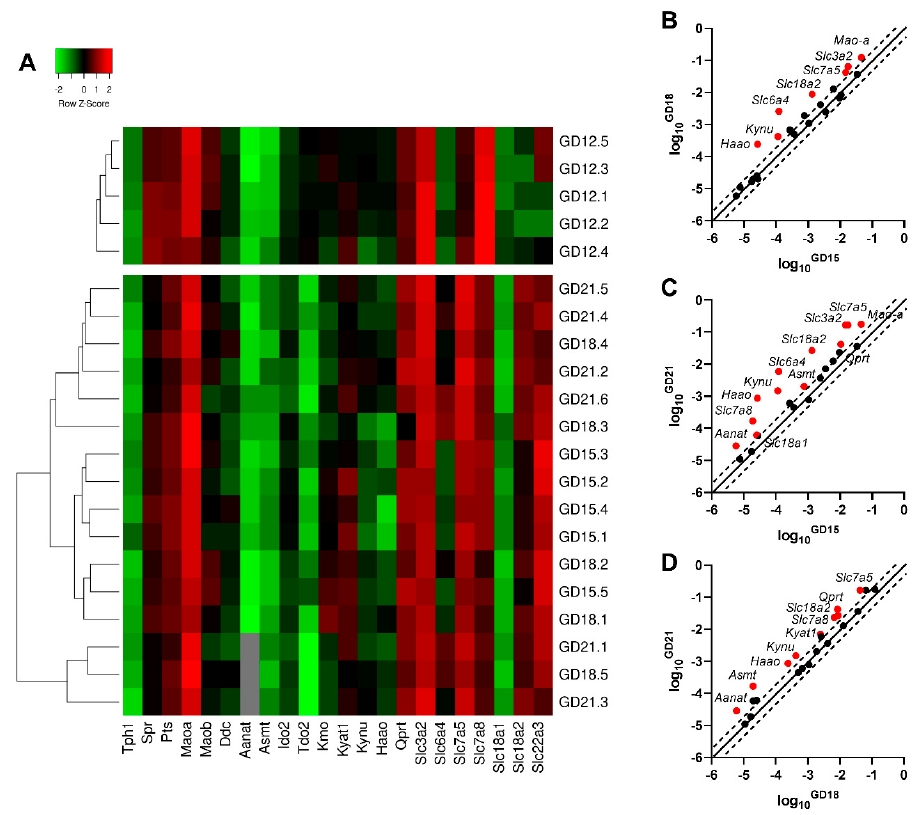
Figure 2. Gene expression of the main enzymes and transporters involved in TRP metabolic pathways in the rat placenta at different stages of gestation. ( A ) Heatmap representing qPCR gene expression analysis in rat concepti (GD 12) and the rat placenta (GD 15, 18, and 21). Average linkage clustering with Euclidean distance measurement reveals changes in gene expression that reflect the different stages of placental development. The color intensity indicates expression levels: red = upregulation; green = downregulation; and gray = not detected. ( B – D ) Identification of enzymes/transporters with significant changes in placental gene expression during gestation. Whilst the pattern of the increase in gene expression is similar for di ff erent stages of gestation, the highest di ff erence is observed between GD 15 and 21. Data are presented as scatter plots with log10 gene expression at GD 18 compared to GD 15 ( B ), GD 21 compared to GD 15 ( C ), and GD 21 compared to GD 18 ( D ). The central diagonal line shows unchanged gene expression, and the dotted lines depict the threshold fold regulation ( = 2). Data were further evaluated using the non-parametric Mann–Whitney test on ∆ Ct values, and those which exceeded the threshold fold change (FC) and were statistically significant are highlighted in red and